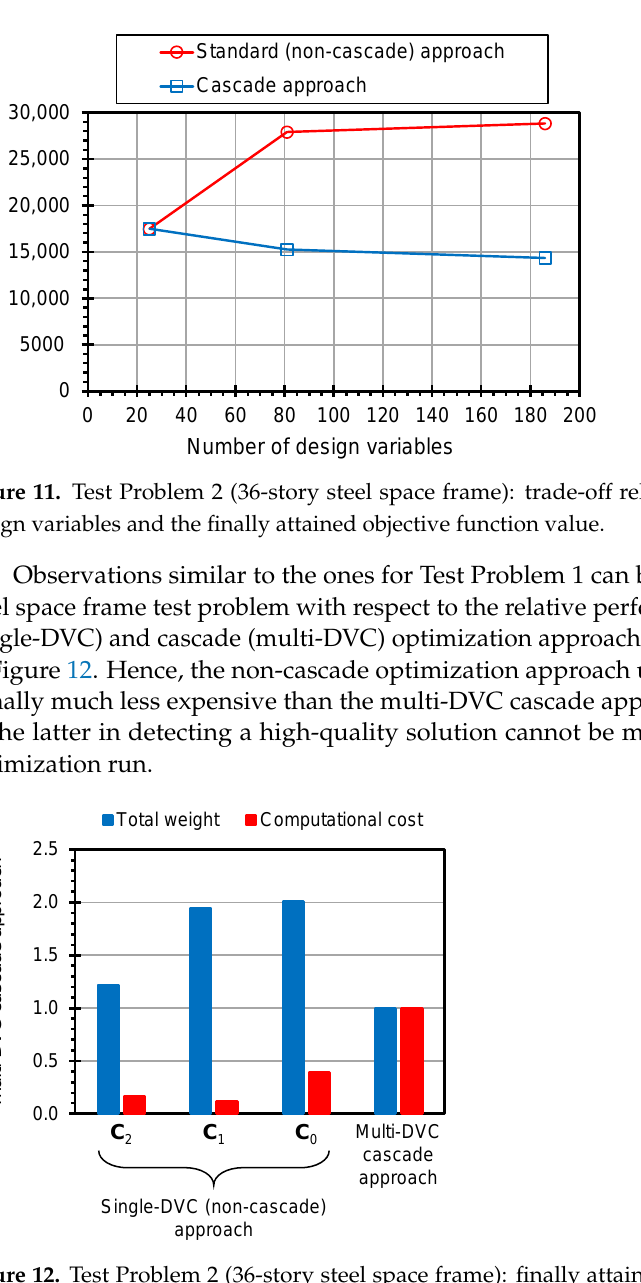
Figure 12. Test Problem 2 (36-story steel space frame): finally attained material weight and corre- sponding computational cost for various optimization runs. The results are given as ratios, relative to the performance of the multi-DVC cascade optimization